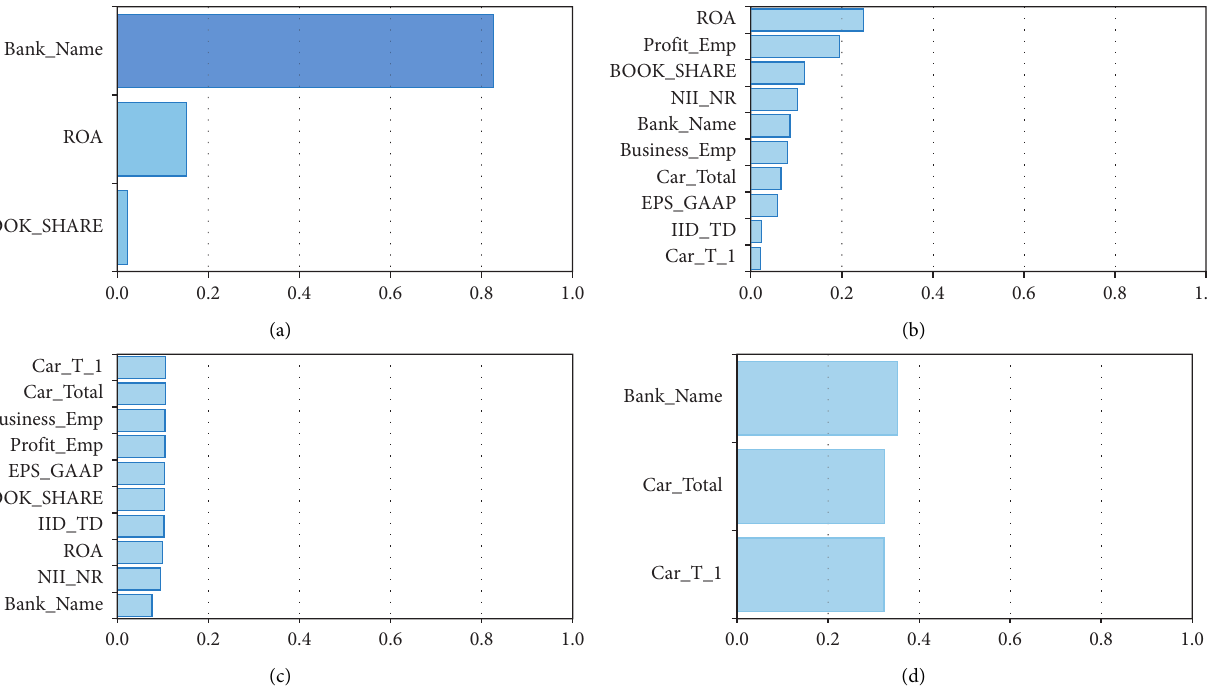
Figure 3: Importance predictors by using four prediction models including (a) linear regression, (b) neural network, (c) SVM, and (d) CHAID based on feature selection model.